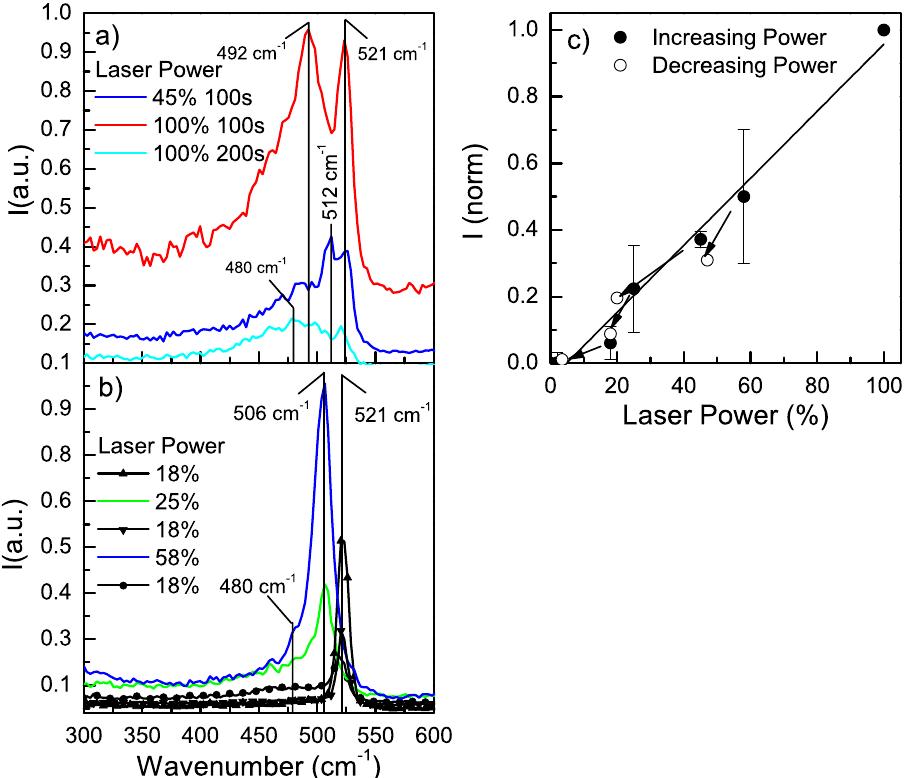
Figure 3. ( a ) Raman spectra were taken at 532 nm for different laser power as specified in the figure (% of the maximum power). At the maximum power (100%) a 100 s irradiation time produces a partial melting of the Si-NP while a 200 s irradiation time a full melt; ( b ) Raman peak intensity of the crystal component as a function of the laser power, showing, during a sequence of heating/cooling processes the partial melting/crystallization process of the Si-NP. ( c ) Normalized Raman peak intensity of the 521 cm −1 crystal component as a function of the laser power, showing a linear dependence of the peak position on the irradiation power;